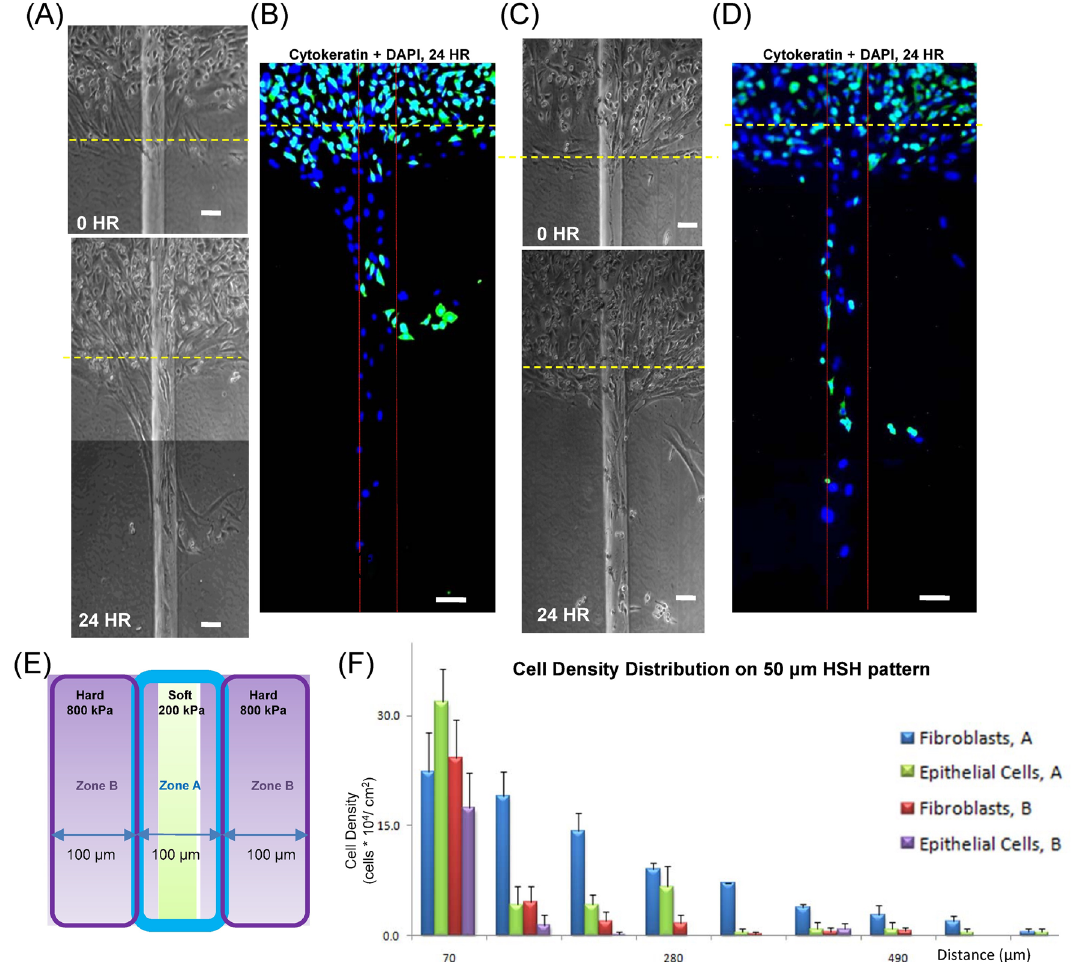
Figure 8. A549 epithelial cells and WI-38 fibroblasts co-cultured motility for the vertical configuration with cells moving along the length of the rectangular strip with a width of 50 μm in our HSH system. ( A ) The co-culture was imaged with phase contrast at 0 h and 48 h after being released. ( B ) Immunofluorescent images were captured after 24 h as well. A second representative response of the A549 epithelial cells and WI-38 fibroblast response at ( C ) 0 and 48 h, and ( D ) with immunofluorescence. ( E ) A diagram indicating the location of zone A and zone B on the HSH substrate for ( F ) quantifying the motility of the A549 epithelial cells and WI-38 fibroblasts on the vertical HSH substrate. Green pseudo-coloring for was for Cytokeratin and A549 epithelial cells and blue pseudo-coloring was for DAPI and the nucleus. The fibroblasts and epithelial cells on the HSH substrate were statistically significant (P value is 0.01 for zone A and 0.2 for zone B) and thus less than